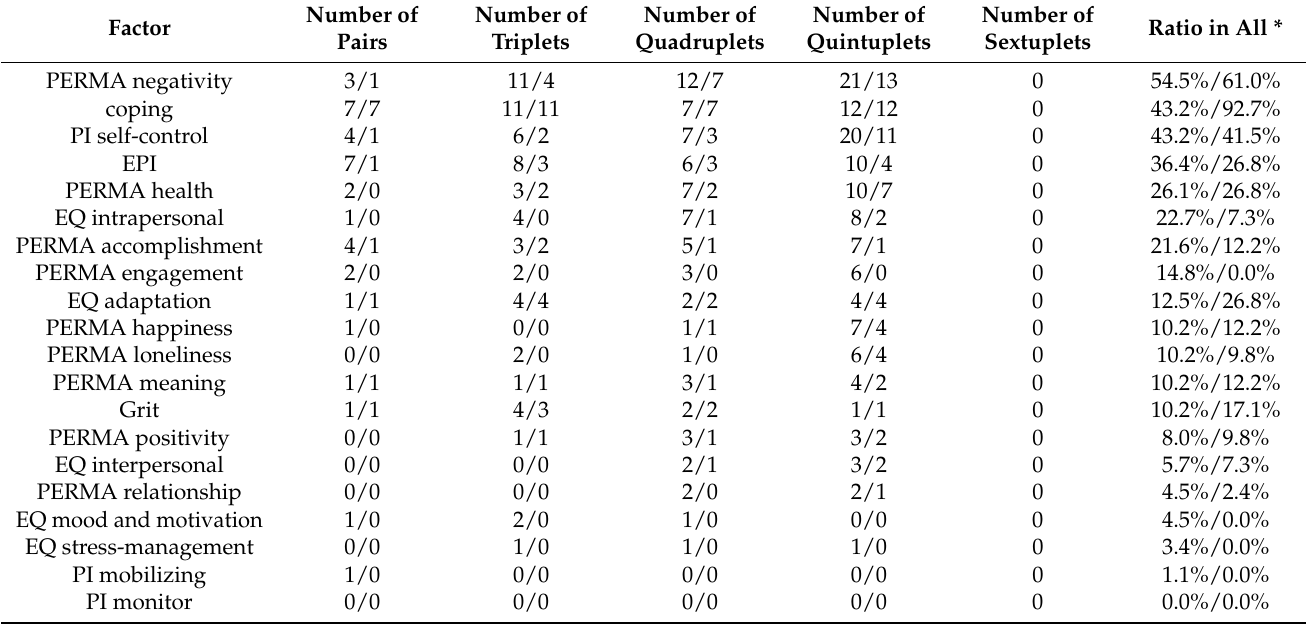
Table 3. The number of groups (pairs, triplets, quadruplets, quintuplets, sextuplets) and the ratio of all groups with additional incremental predictive power where the given factor contributes to. The second number in each column reflects to the number and ratio of groups out of the groups with incremental predictive power that have significant prediction gain (at the 0.1 level) compared to the prediction power of the UES. * The ratio in all column shows what percentage of all factor groups with (significant) incremental power the given factor was included in. This is a good metric for finding what factors increase the predictive power typically.